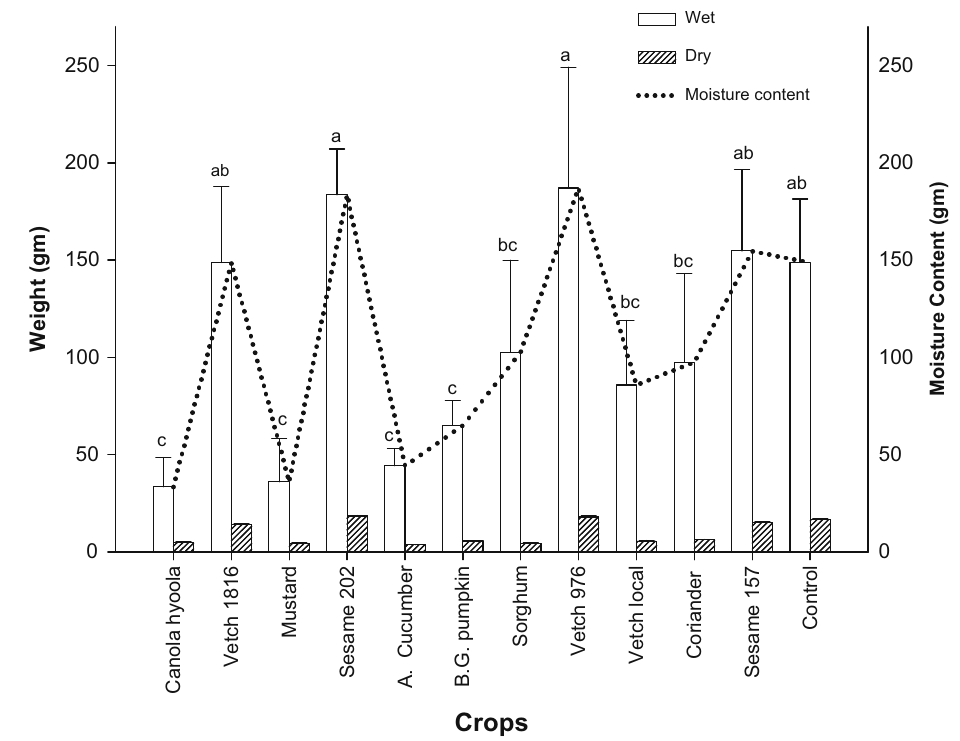
Figure 3: E ff ects of arti fi cial inoculation with Meloidogyne spp. and 11 trap crops on shoot fresh and shoot dry weight ( g/plant ) of lettuce plants ( left - axis ) and moisture content ( g/plant ) ( right - axis ) . The standard deviation of the means is designated by the error bar for each mean. Means followed by the same letter are not signi fi cantly di ff erent ( SNK, P > 0.05 )